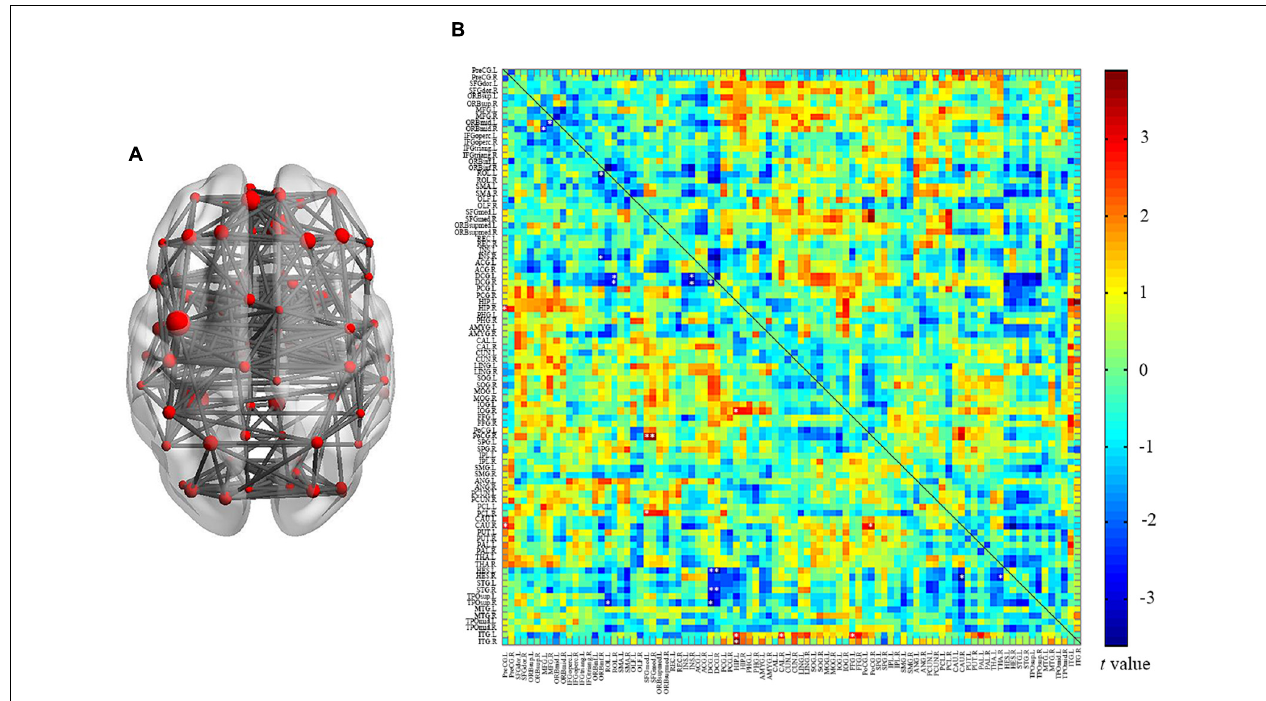
FIGURE 4 | Between group analysis of internal cortical connectivity among 90 nodes from the AAL atlas. (A) Network construction of 90 nodes; (B) a matrix map of internal connectivity indicates t values of interactions. Significant p was set at < 0.005, uncorrected.